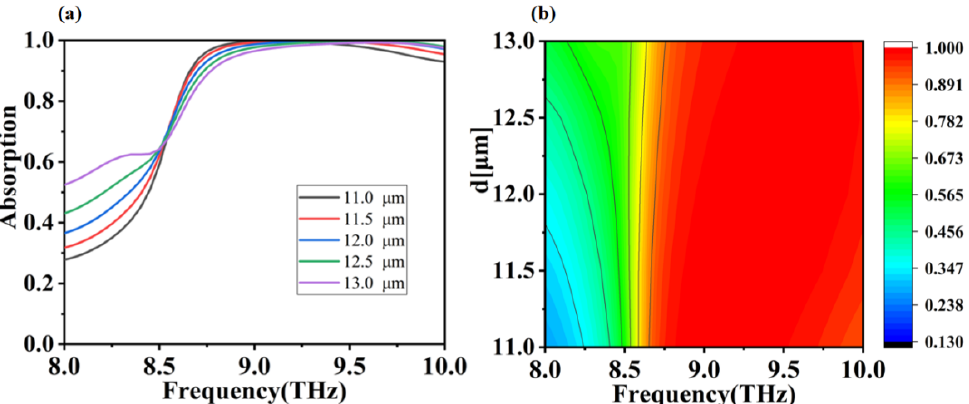
Figure 5. ( a , b ) are absorption simulation images of scanning medium layer thickness (11–13 µm) at frequency from 8.0 to 10.0 THz, respectively.